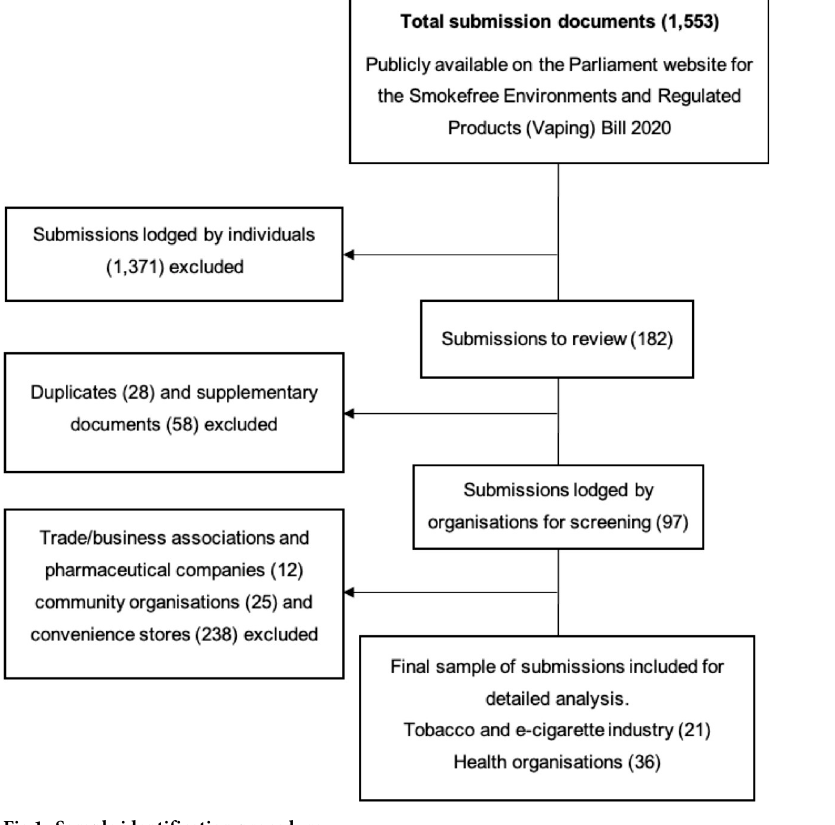
Fig 1. Sample identification